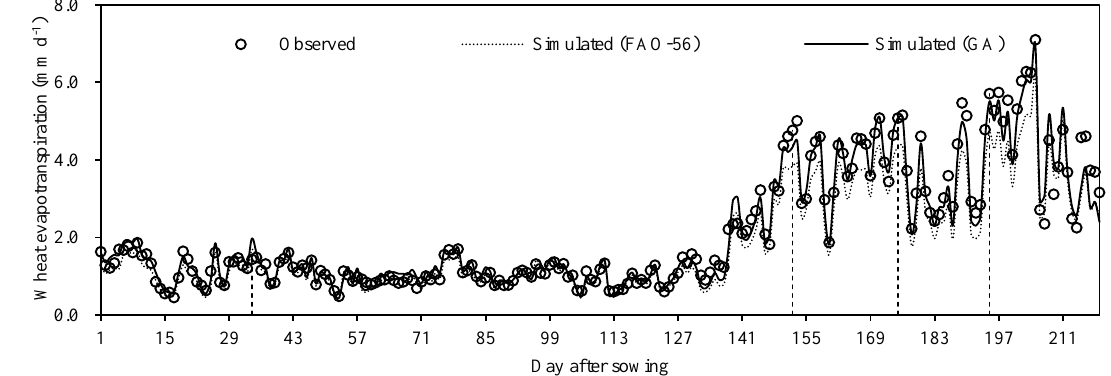
Figure 4. Observed and simulated daily winter wheat evapotranspiration under full irrigation during the whole growth period. Evapotranspiration is estimated based on the crop coefficients that are optimized by the genetic algorithm (GA) and recommended by the FAO-56. Stage I: seedling stage;